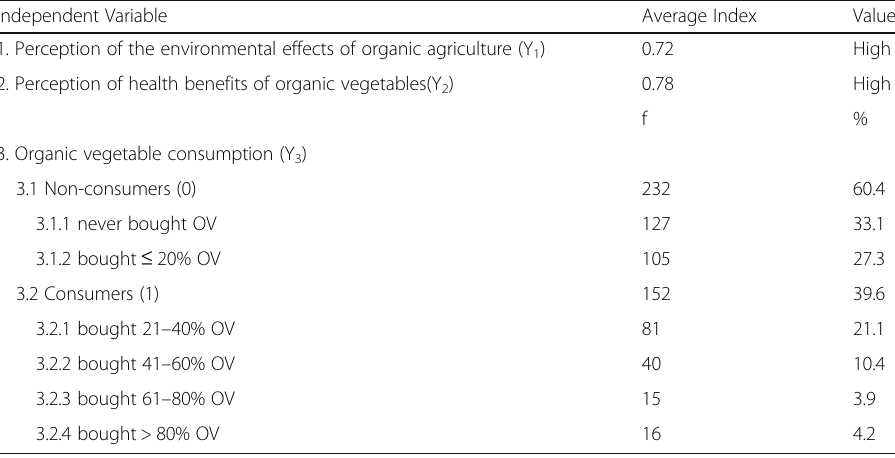
Table 1 Dependent variables included in the Stepwise Multiple Linear and Binary Logistic Regression Models ( n =